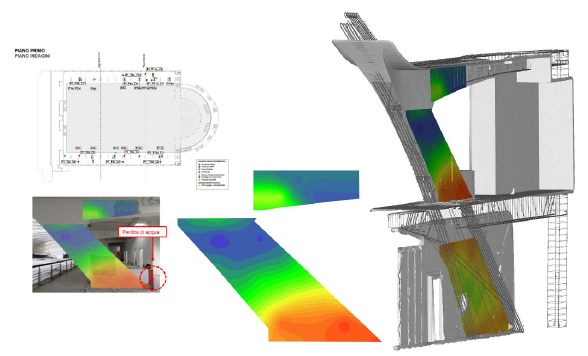
Figure 15 . Corrosion potential map for one of the P12n pillar module, projected on the reality-based mesh; integration between the textured model and the irons reinforcement (modelled from the original Nervi’s project drawings).